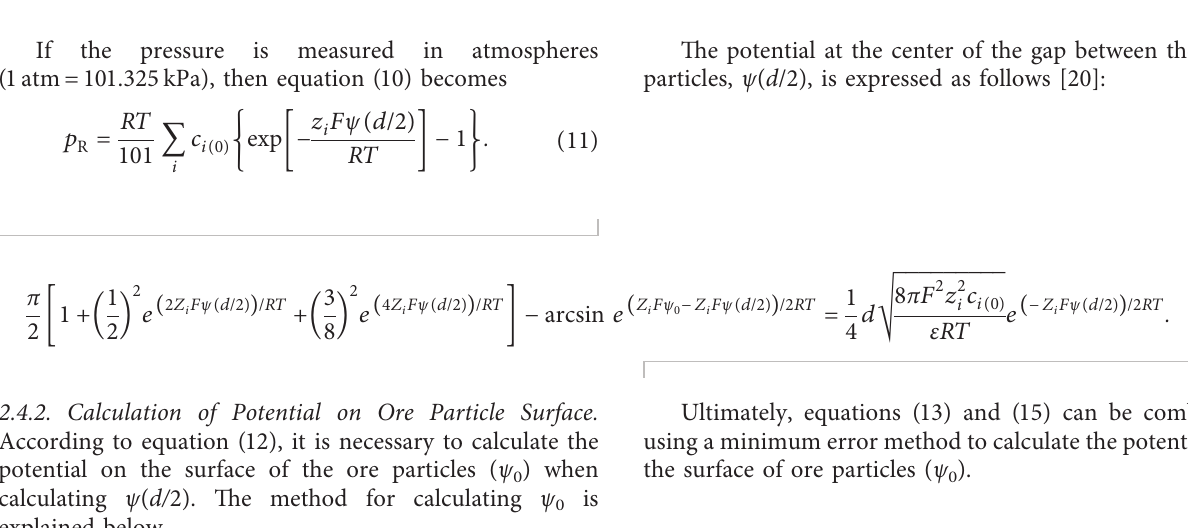
Figure 1: Interaction between the double electric layers associated with a pair of particles assumed to behave like parallel